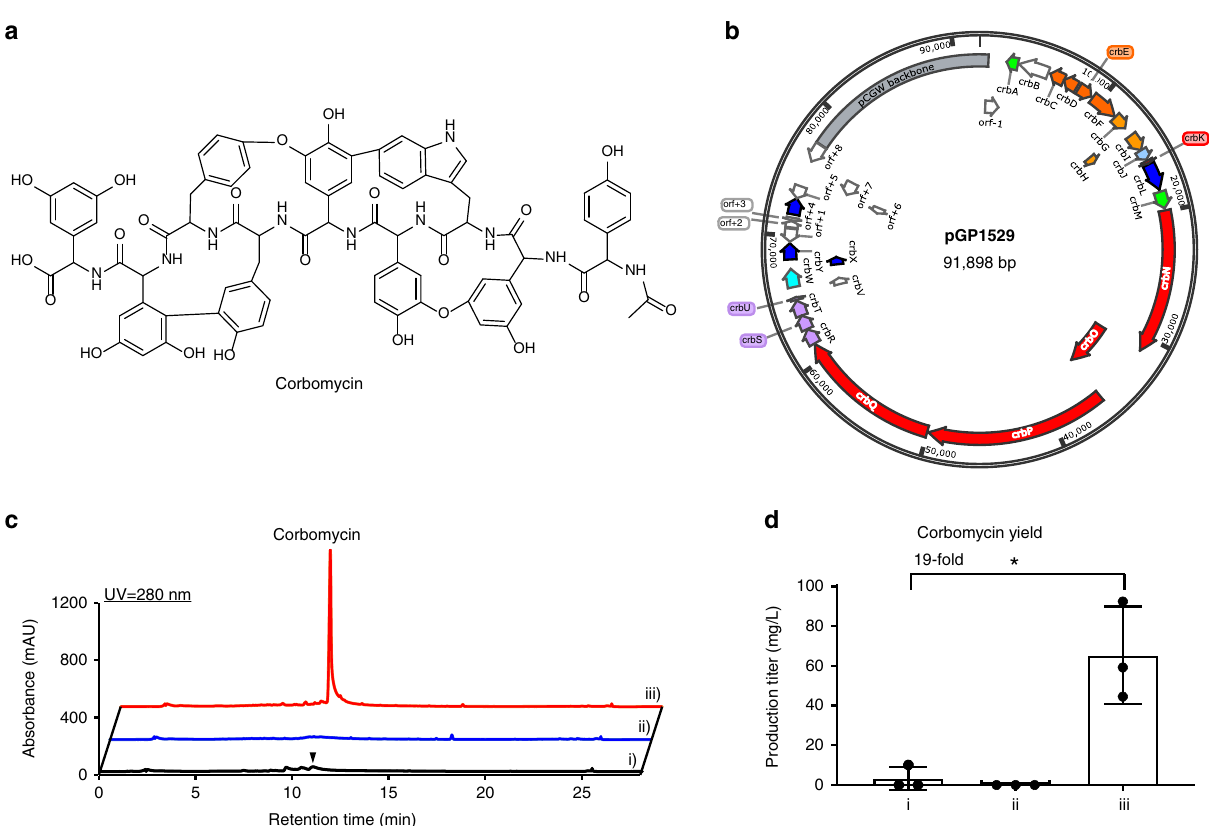
Fig. 2 Production of corbomycin using GPAHex. a Chemical structure of corbomycin. b pGP1529 bearing crb BGC captured through TAR. Genes are color- coded as in Fig. 1 with the addition of red (NRPS scaffold and mbtH genes) and purple (P450s genes). c Heterologous expression of corbomycin using GPAHex. The inverted triangle represents the small corbomycin peak produced by the parental strain S . sp. WAC01529 (i)). No corbomycin was detected in S. coelicolor M1154 (ii)), while a large corbomycin peak was evident in the GPAHex production chassis ’ trace (iii)). d Quanti fi cation of corbomycin production. Production of corbomycin in the GPAHex production chassis (iii)) was increased 19-fold compared to the parental strain S . sp. WAC01529 (ii)). Mean with error bar showing s.d. of three biological replicates ( n = 3) is plotted. Signi fi cance was tested to * P = 0.0131 by an unpaired two-sided Student ’ s t -test. Similar results ( d ) were obtained from two independent